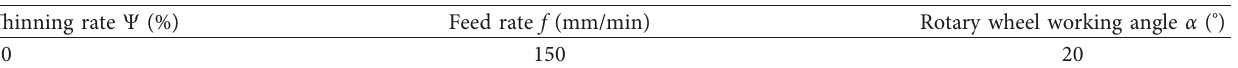
Figure 15: Wall thickness difference trend chart. A: rotary wheel working angle α ( ° ); B: thinning rate Ψ (%); C: feed rate f (mm/min). Table 6: Orthogonal test recommended process parameters.